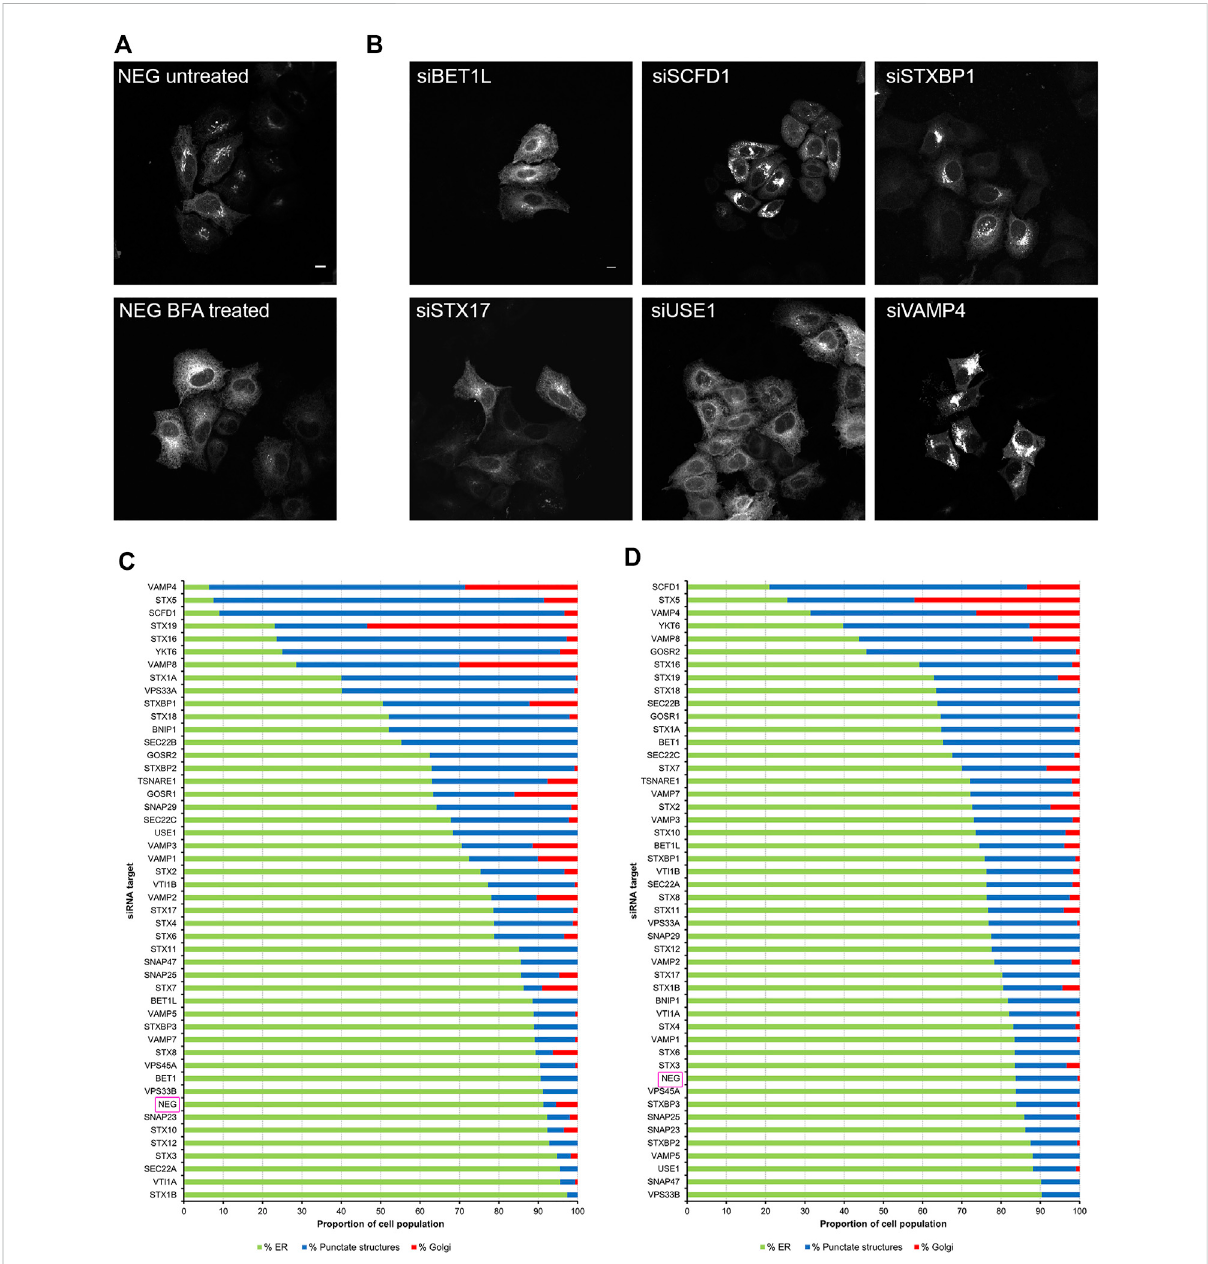
FIGURE 1 Golgi redistribution assay in EGFP-Rab6A transfected cells. Cells were transfected with siRNAs for 48 h, followed by transfection with either EGFP-Rab6A or EGFP-Rab6A ′ constructs for 12 h. Cells weretreated with 10 μ g/ml BFA for 15 min at37 ° C and then fi xedand stained with 0.2 μ g/ml Hoechst33342. (A) RepresentativeconfocalimagesofsiNEG-treatedEGFP-Rab6AexpressingHeLaKyotocells,eitheruntreatedortreatedwithBFA. Scale bar: 10 µm. (B) Representative confocal images of BFA treated EGFP-Rab6A expressing HeLa Kyoto cells incubated with various siRNAs against SNARE or SNARE-like proteins. Images represent different phenotypes observed. Scale bar: 10 µm. (C) Quantitative analysis of the EGFP- Rab6A redistribution assay. A minimum of 100 cells transfected with EGFP-Rab6A constructs were analysed per siRNA treatment (y-axis) and categorised into three phenotypic groups, namely ER (green bars) — cells displaying a high fl uorescent signal in peripheral areas; punctate structures (blue bars) — cells with a distribution of fl uorescent signals in juxta-nuclear punctate structures; and Golgi (red bars) — cells with an intense juxta- nuclear signal. The percentage of cells per treatment within each group is displayed on the x-axis. Data are represented as the mean of two independent experiments. (D) Quantitative analysis of the EGFP-Rab6A ′ redistribution assay. A minimum of 100 cells transfected with EGFP-Rab6A ′ constructs wereanalysed persiRNA treatment (y-axis) and categorisedintothree phenotypicgroups, asfor (C) .Dataare represented as themeanof two independent